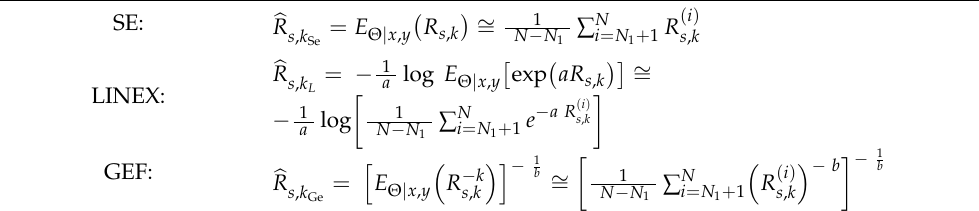
Table 1. Three loss functions and corresponding Bayes estimator.